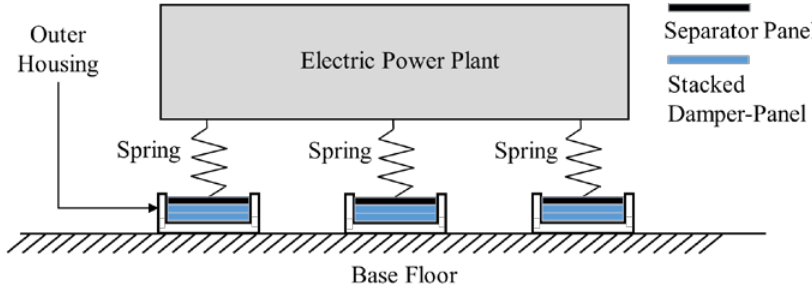
Figure 4. Mount diagram of proposed mount module.